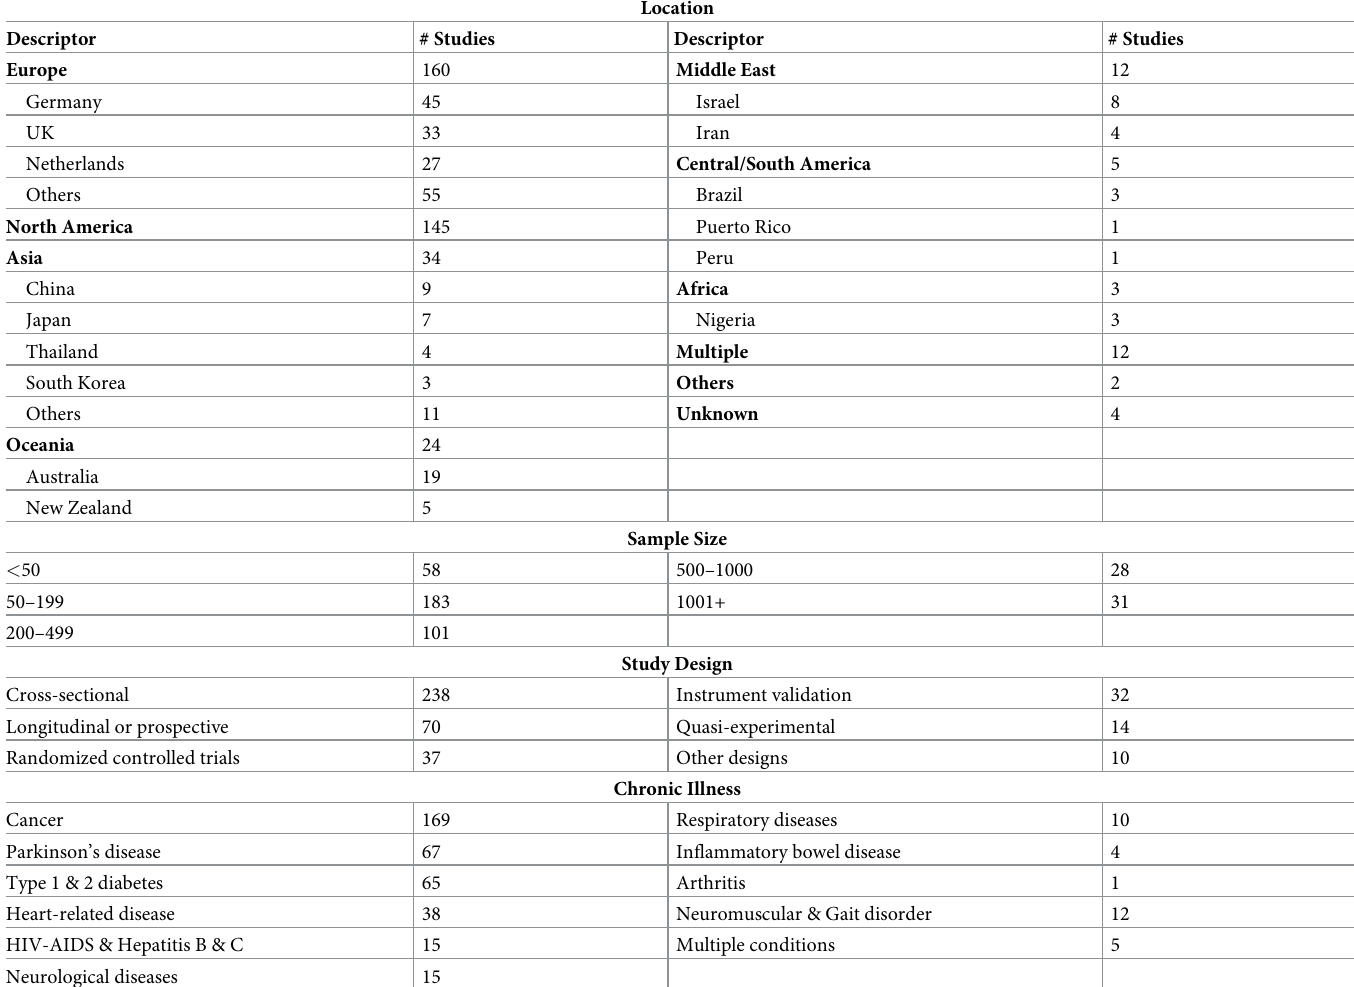
Table 2. Description of studies by location, sample size, study design, and chronic illness (k =